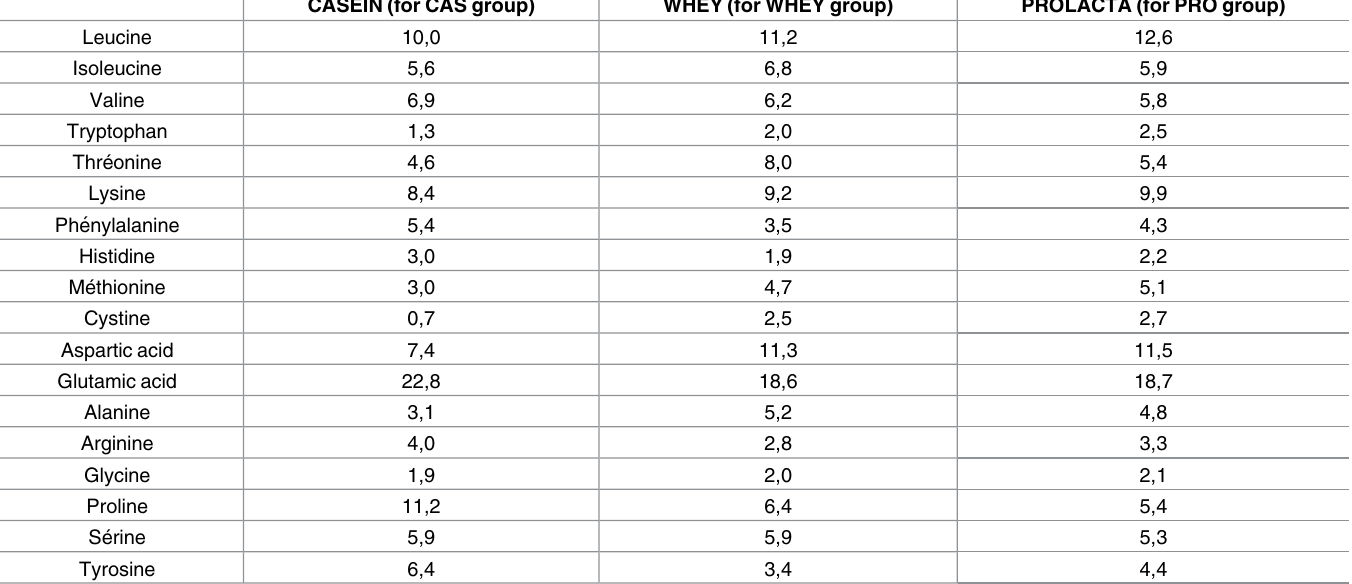
Table 1. Amino acids composition of